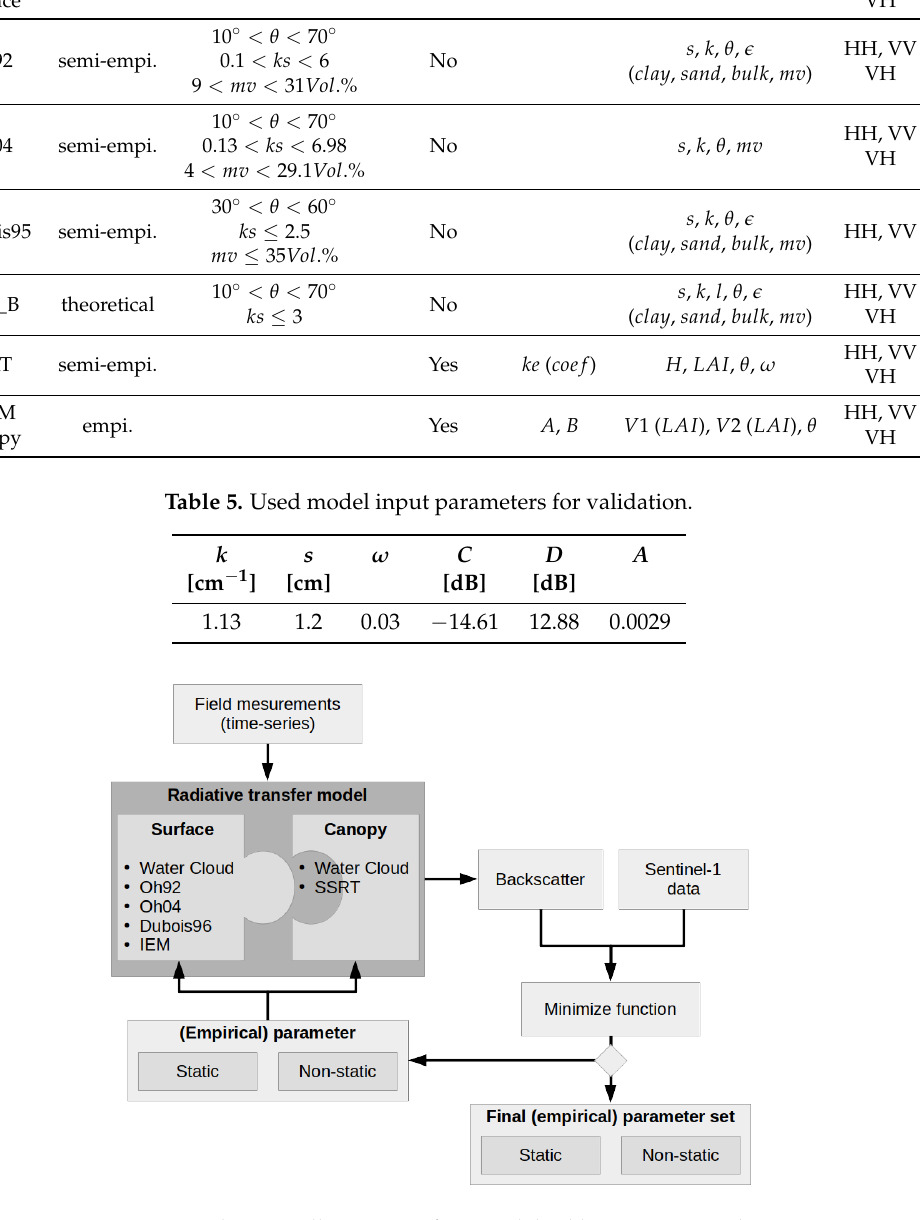
Figure 3. Schematic illustration of RT model calibration